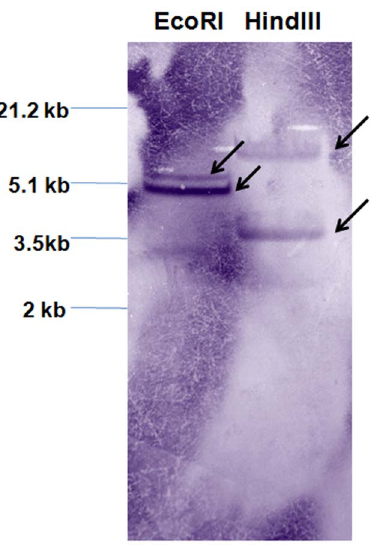
Figure 2. Copy number analysis of VrNHX1 in mungbean genome. Mungbean genomic DNA (20 m g) was digested with EcoRI and HindIII, and hybridized with DIG-labeled probe corresponding to the CDS of VrNHX1 . Hybridization signals are indicated as arrows.